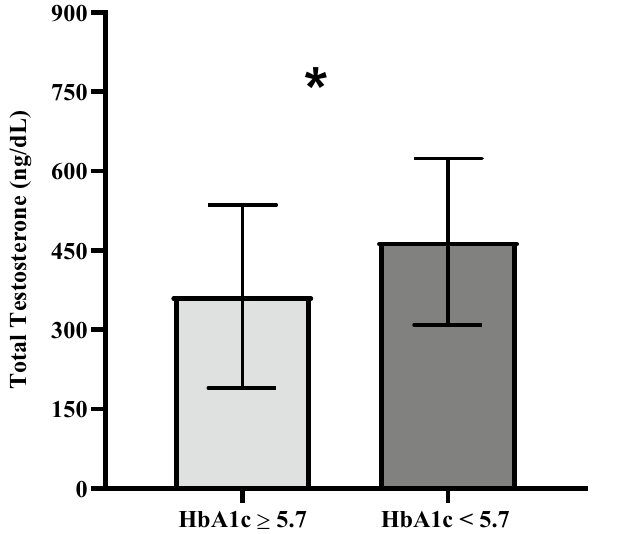
Figure 2. Serum Total testosterone levels (Mean ± SD) in firefighters with increased (n = 40) vs normal Hb1Ac (n = 258); *(p < 0.05; T-test).